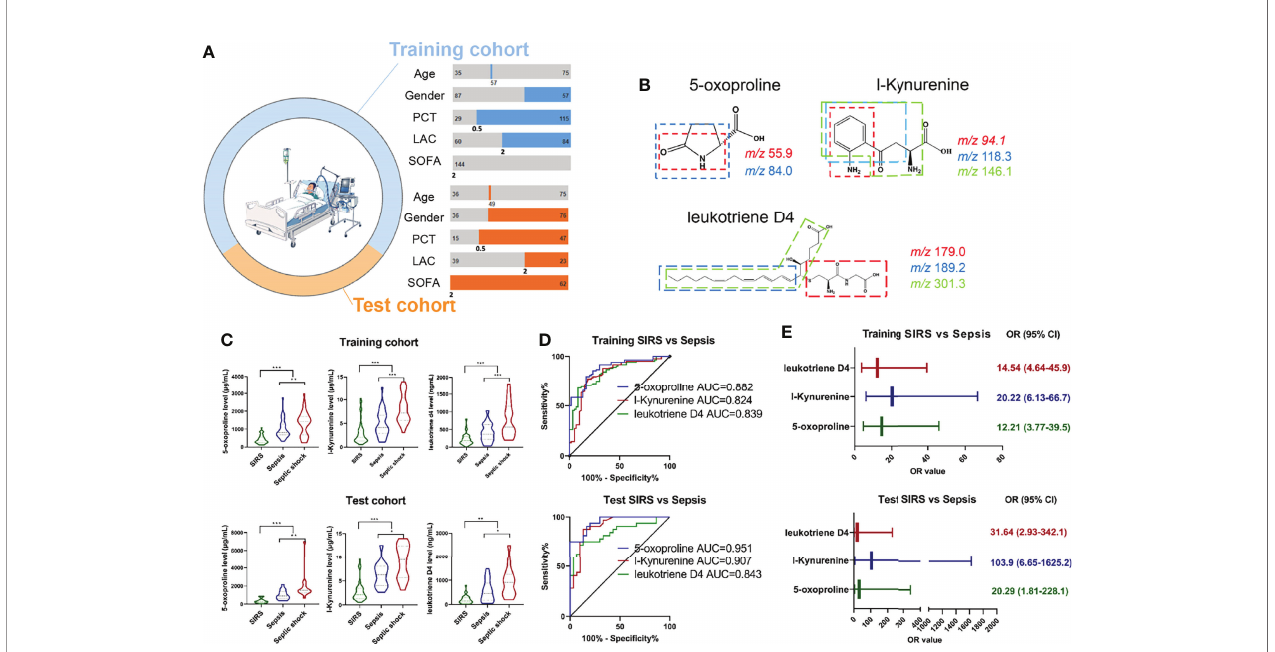
FIGURE 3 | Development of MRM based target metabolite quanti fi cation method and detection of the abundance of 3 target metabolites including 5-Oxoproline, L- Kynurenine and Leukotriene D4 in training and test cohort. (A) Demographic and clinical characteristics of enrolled cohort. (B) Chemical structure and fragmentation of 5- Oxoproline, L-Kynurenine and Leukotriene D4. (C) Respective expression of 5-Oxoproline, L-Kynurenine and Leukotriene D4 in the training and test cohorts. (D) ROC analysis of 5-Oxoproline, L-Kynurenine and Leukotriene D4 in predicting sepsis in the training and test cohorts. (E) Odds ratios of 5-Oxoproline, L-Kynurenine and Leukotriene D4 in predicting sepsis. (*, p < 0.05; **, p < 0.01; ***, p <